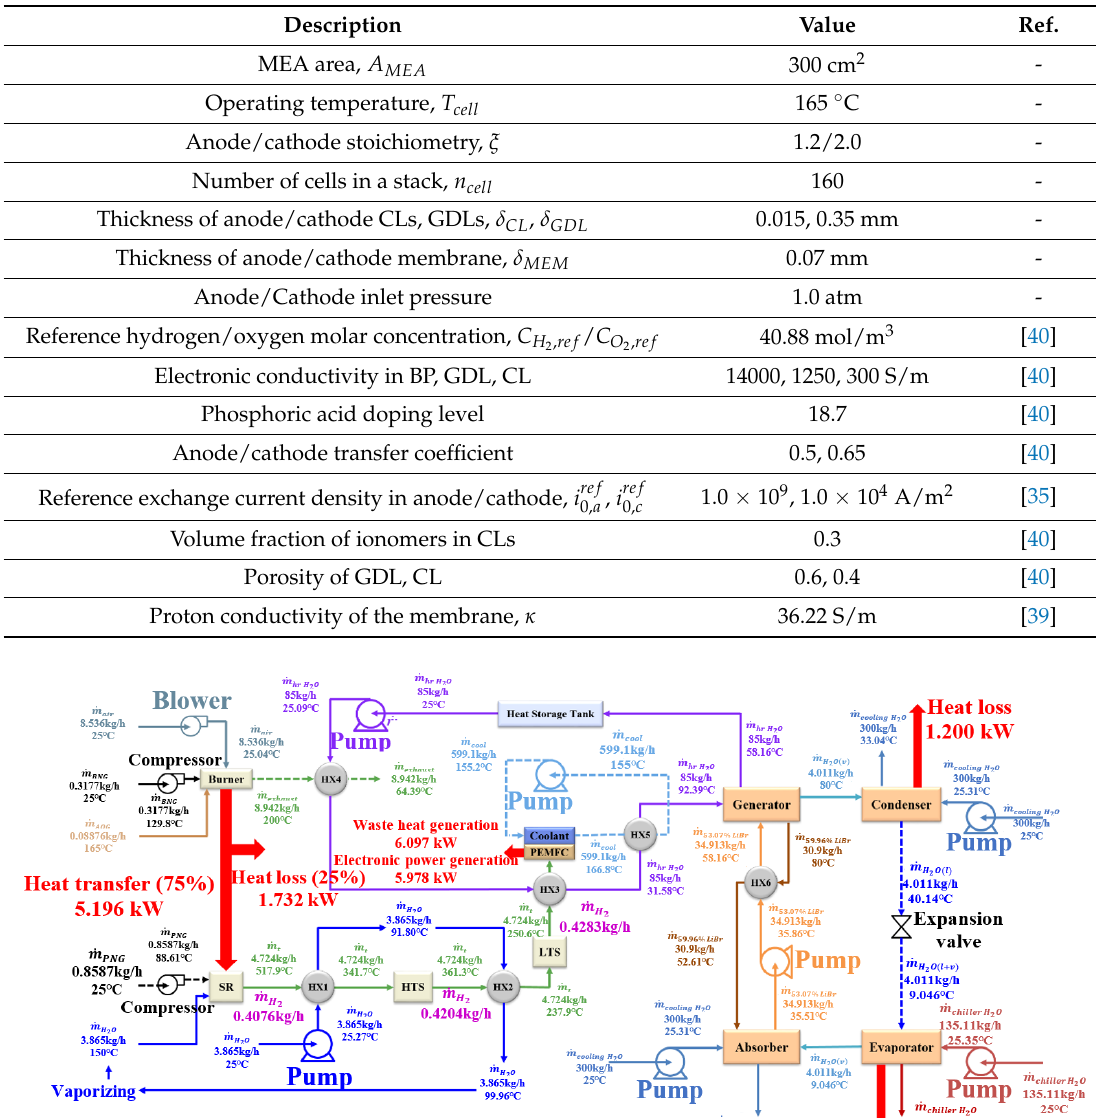
Table 3. Geometric/operating conditions and input parameters for simulations of the HT-PEMFC stack.